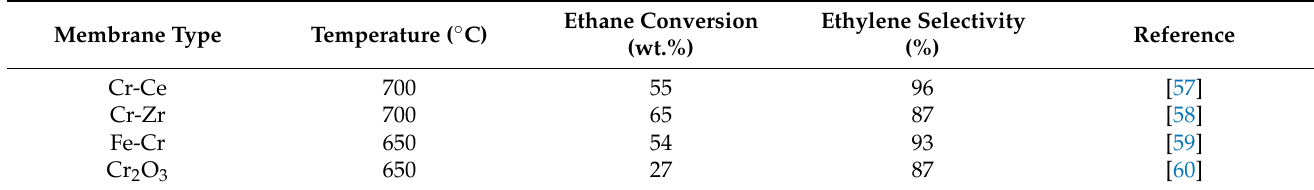
Table 4. Catalytic performance of the different ODH-CO 2